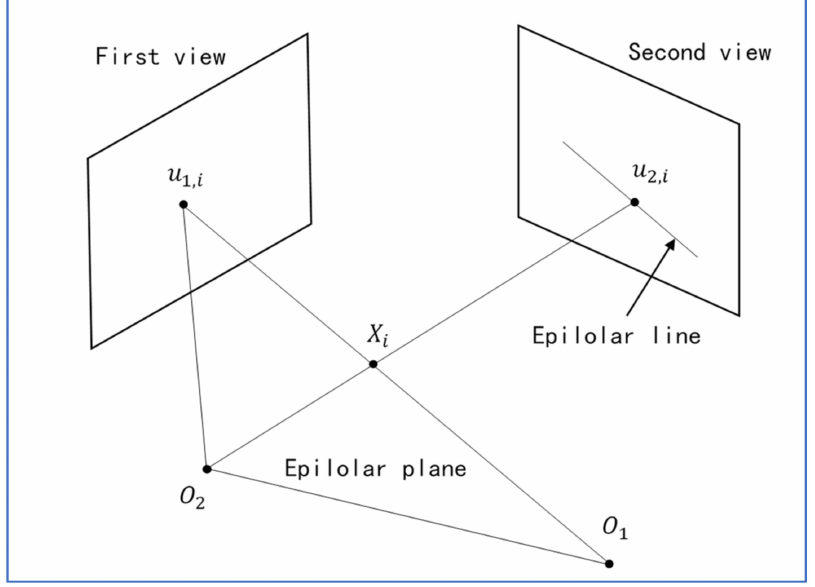
Figure 2. Epipolar constraints for two